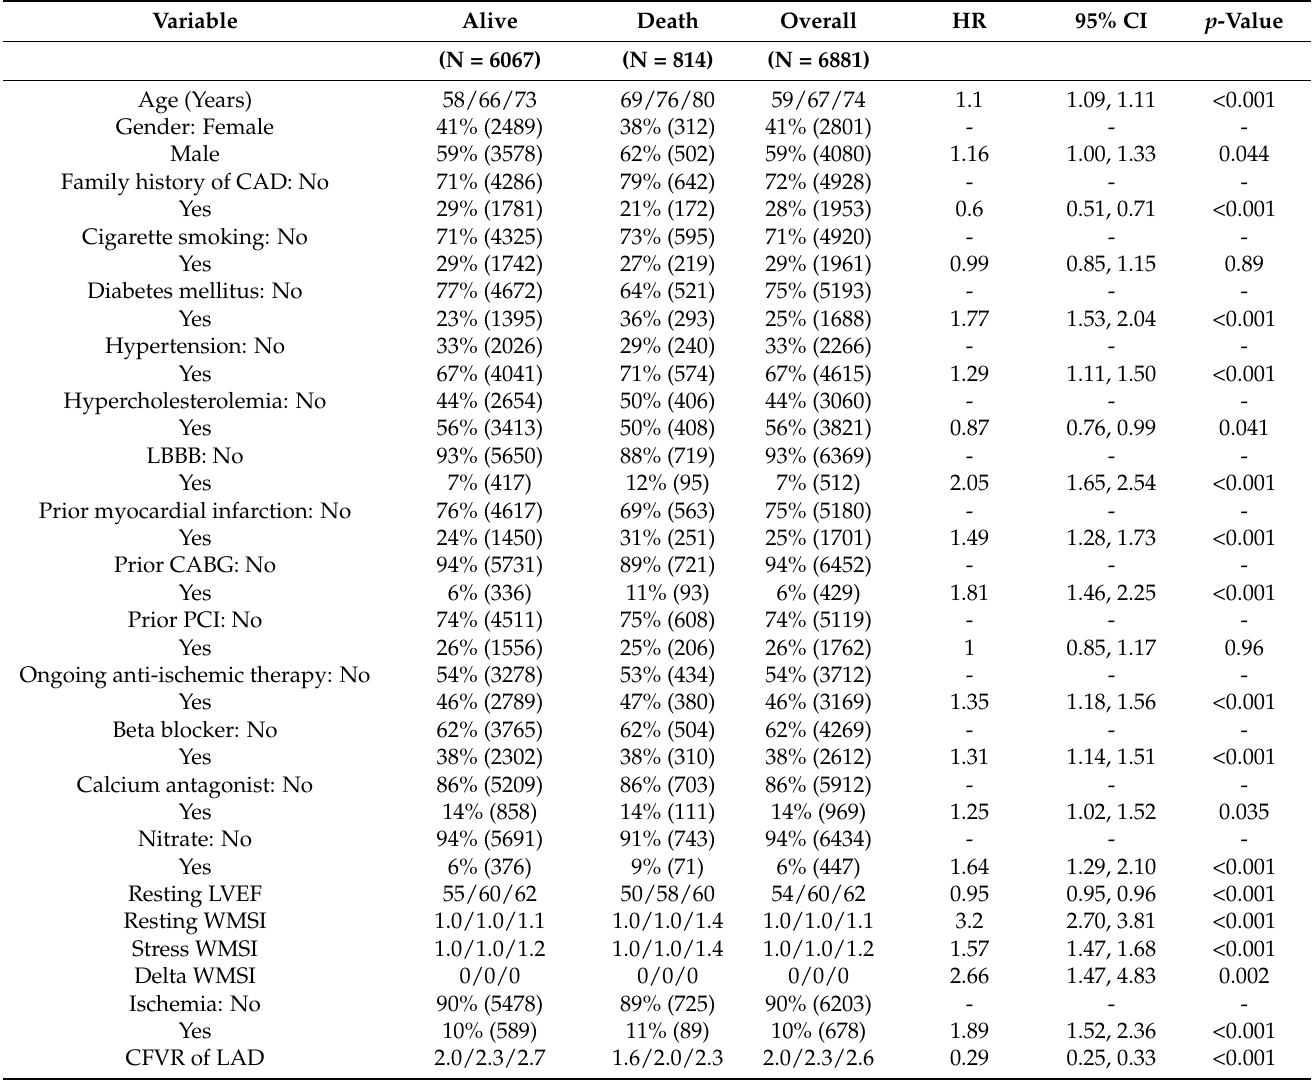
Table 1. Univariable prognostic